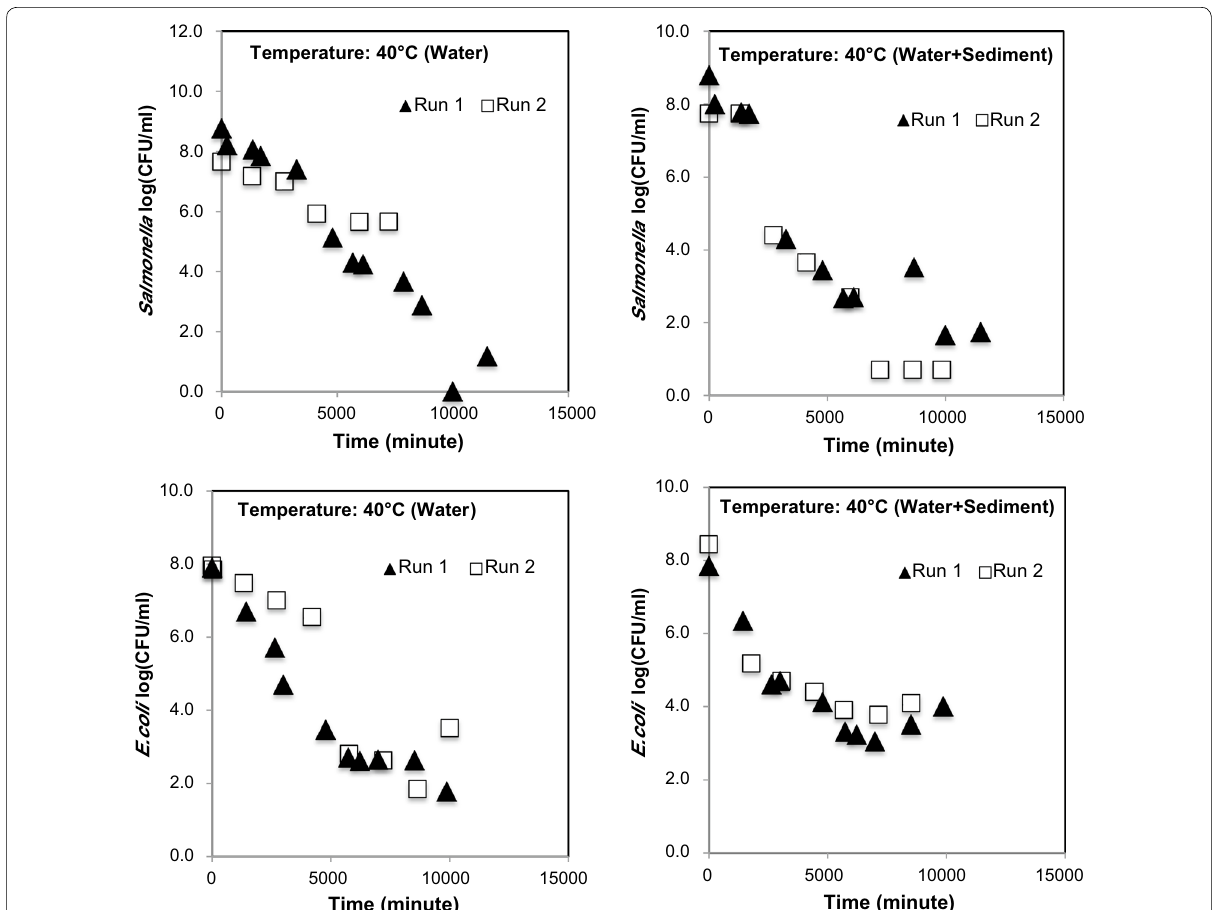
Fig. 4 Survival of Salmonella and E. coli O157:H7 and at 40 °C (mesophilic temperature) in free floating and particle attached